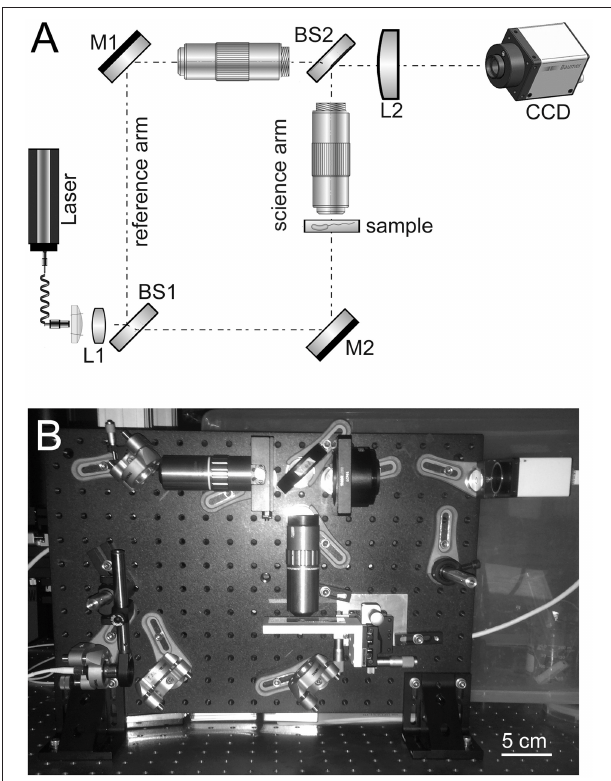
FIGURE 1 | (A) Schematic of high-resolution instrument developed and used in this owrk. M, mirror; L, lens; BS, beamsplitter. (B) Photo of assembled instrument including